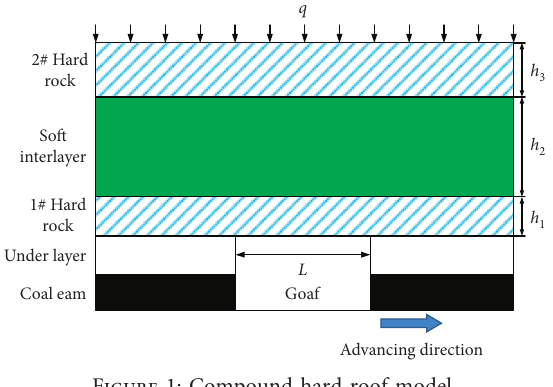
Figure 1: Compound hard roof model.